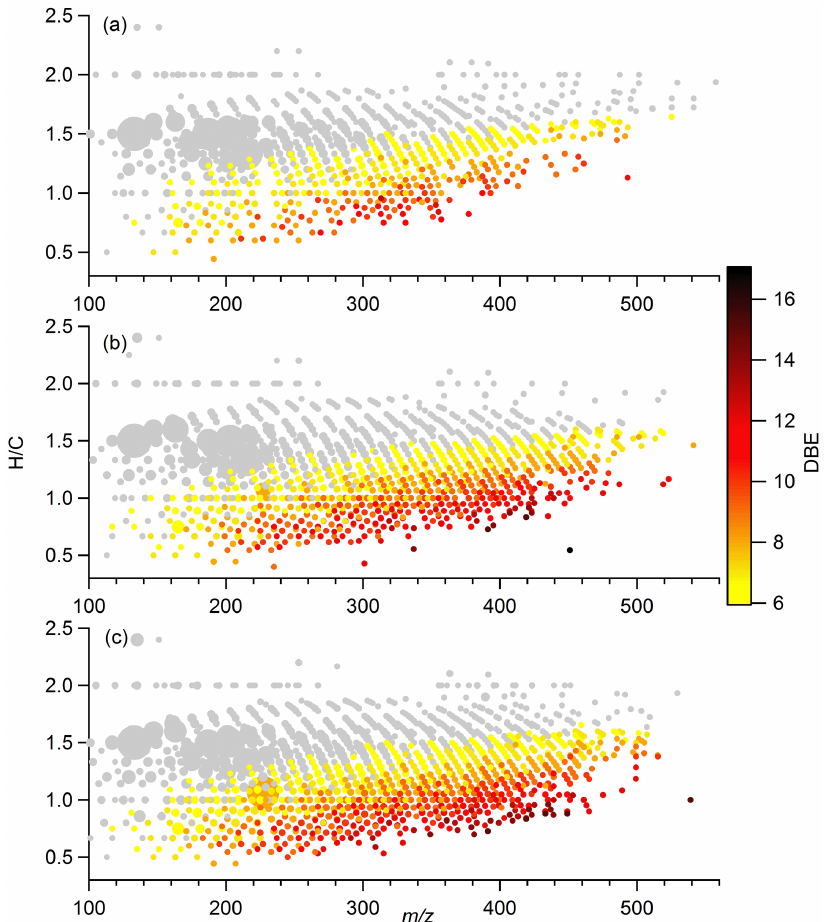
Figure 5. H / C vs. m/z plot for CHO-containing formulae in the samples from the periods with (a) low, (b) moderately high and (c) very high incidents of fires. The marker size reflects relative ion abundance in the sample. The colour code shows double-bond equivalent (DBE) in the individual molecular formula. Molecular formulae with DBE < 6 are shown as grey markers. The largest grey circles correspond to the ions at m/z 133.01425 (with a neutral molecular formula of C 4 H 6 O 5 ) , m/z 187.0612 (C 8 H 12 O 5 ) , m/z 201.07685 (C 9 H 14 O 5 ) , m/z 203.05611 (C 8 H 12 O 6 ) , and m/z 215.05611 (C 9 H 12 O 6 )